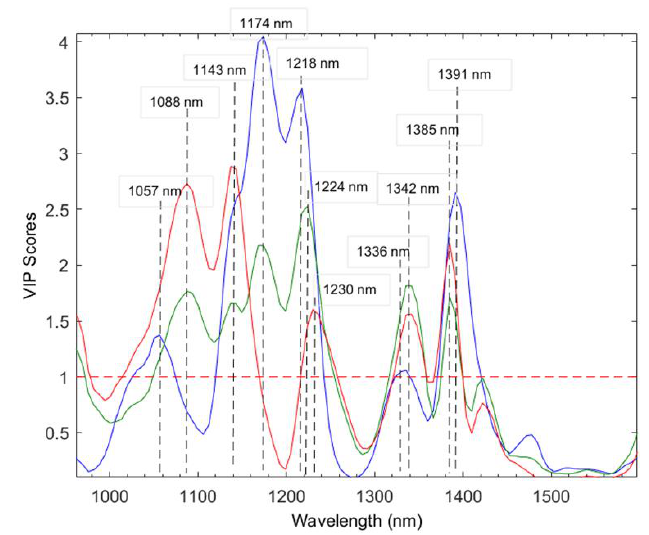
Figure 2. Variable importance in projection (VIP) scores for 11 waveband groups in the PLS-DA (SGd 1 (7) pre-processed) species classification model, where each VIP score above 1 represents an important spectral region.